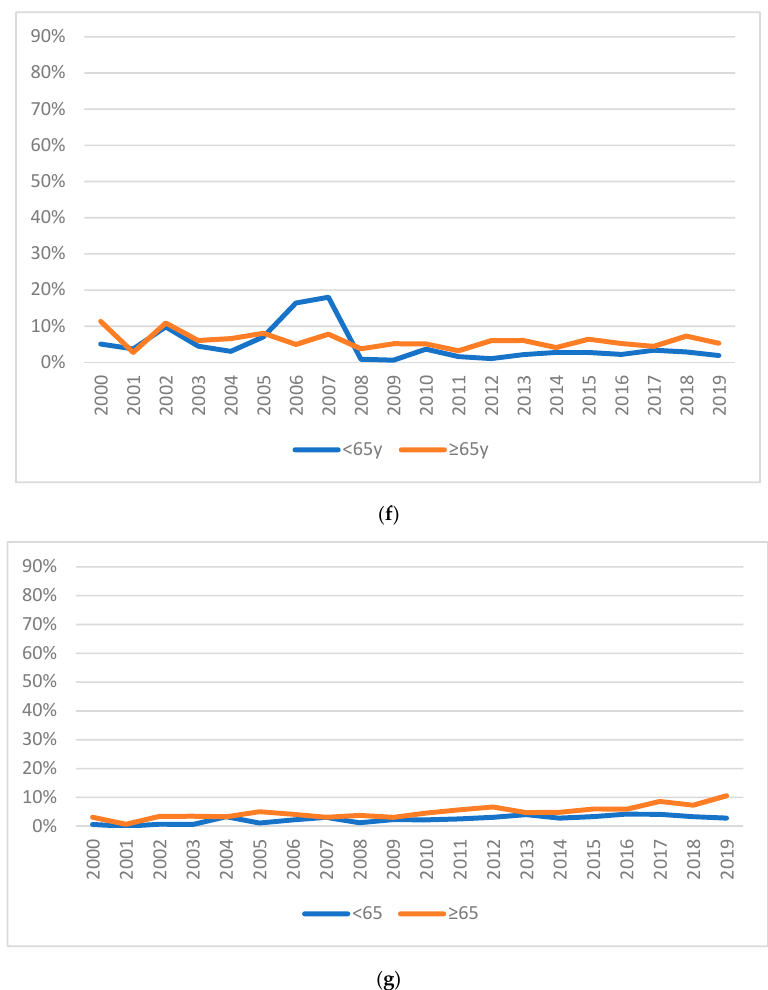
Figure 5. Trends over time of percentage of referrals from wards for the subgroups NOV65 and OV65. ( a ) Internal medicine; ( b ) Oncology; ( c ) Gastroenterology; ( d ) Headache centre; ( e ) Transplant surgery; ( f ) Surgery; ( g ) Nephrology-dialysis.